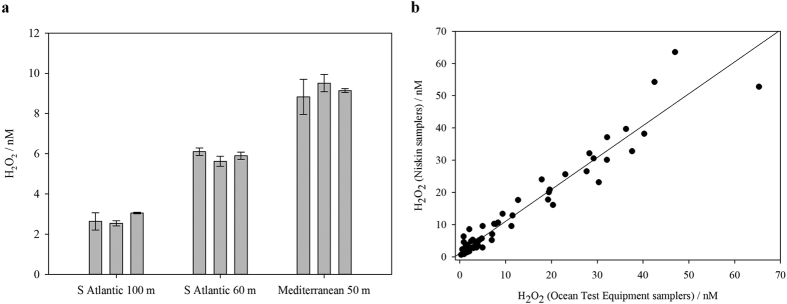
(a) Replicate apparent H2O2 measurements using 3 separate samplers deployed at the same depth. Mean (n = 4 injections) and standard deviation of apparent H2O2 shown. Apparent H2O2 included a signal arising from components other than H2O2 in solution. (b) Comparison between H2O2 samples from two sub-surface sampling methods. Ocean Test Equipment samplers mounted on a powder coated sampling rosette with a Kevlar cable, and Niskin samplers with internal metal components on a standard stainless steel rosette (n = 67 pairs) deployed at the same depths along the South Atlantic transect (December 2015, line of best fit plotted R2 = 0.94).